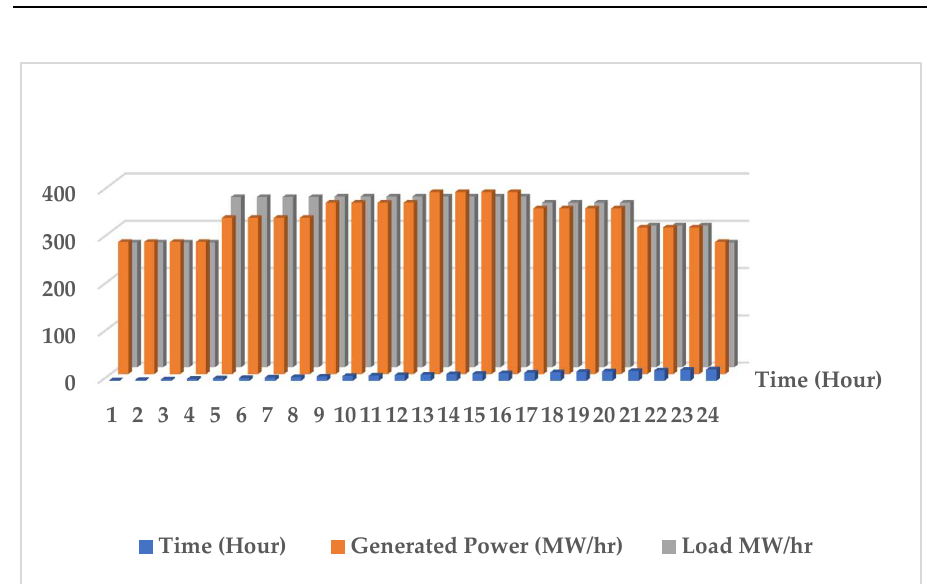
Figure 5. Modernized energy exchange over a single day.